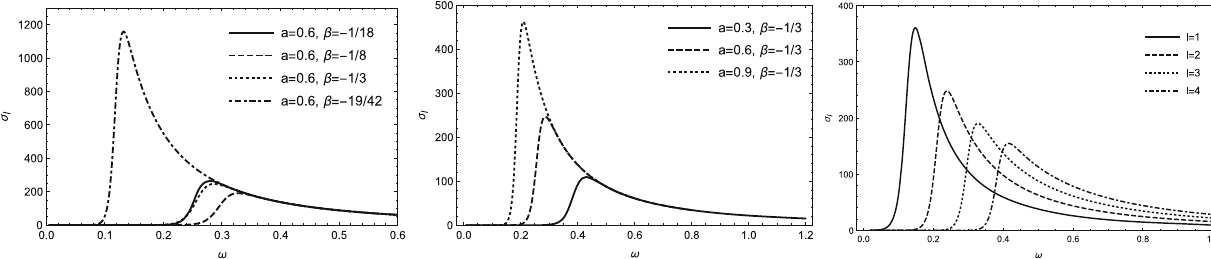
, l = 3 in the left panel and the variable is β at 10